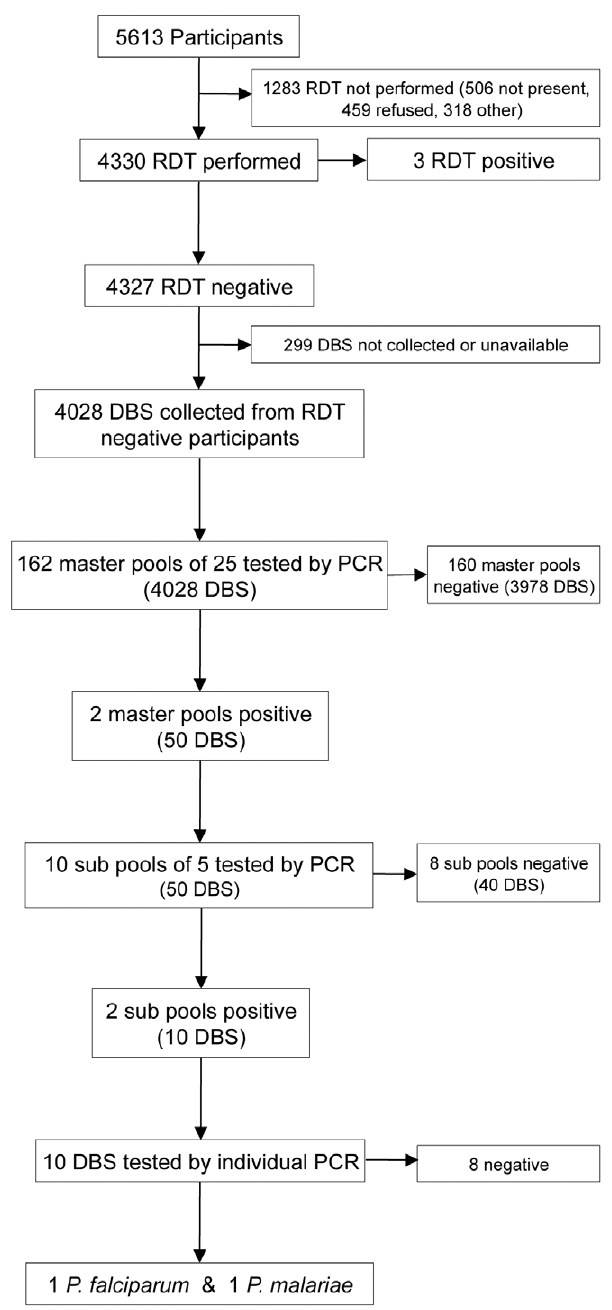
Figure 1. Participant recruitment and results for testing by RDT and pooled-PCR. DBS, dried blood spots.